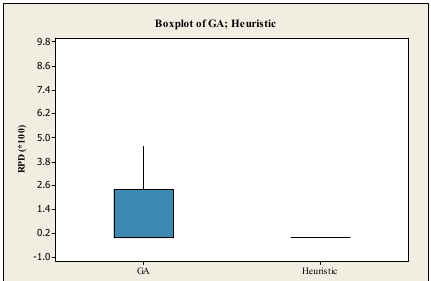
Fig. 6. Comparison of the two solution methods: